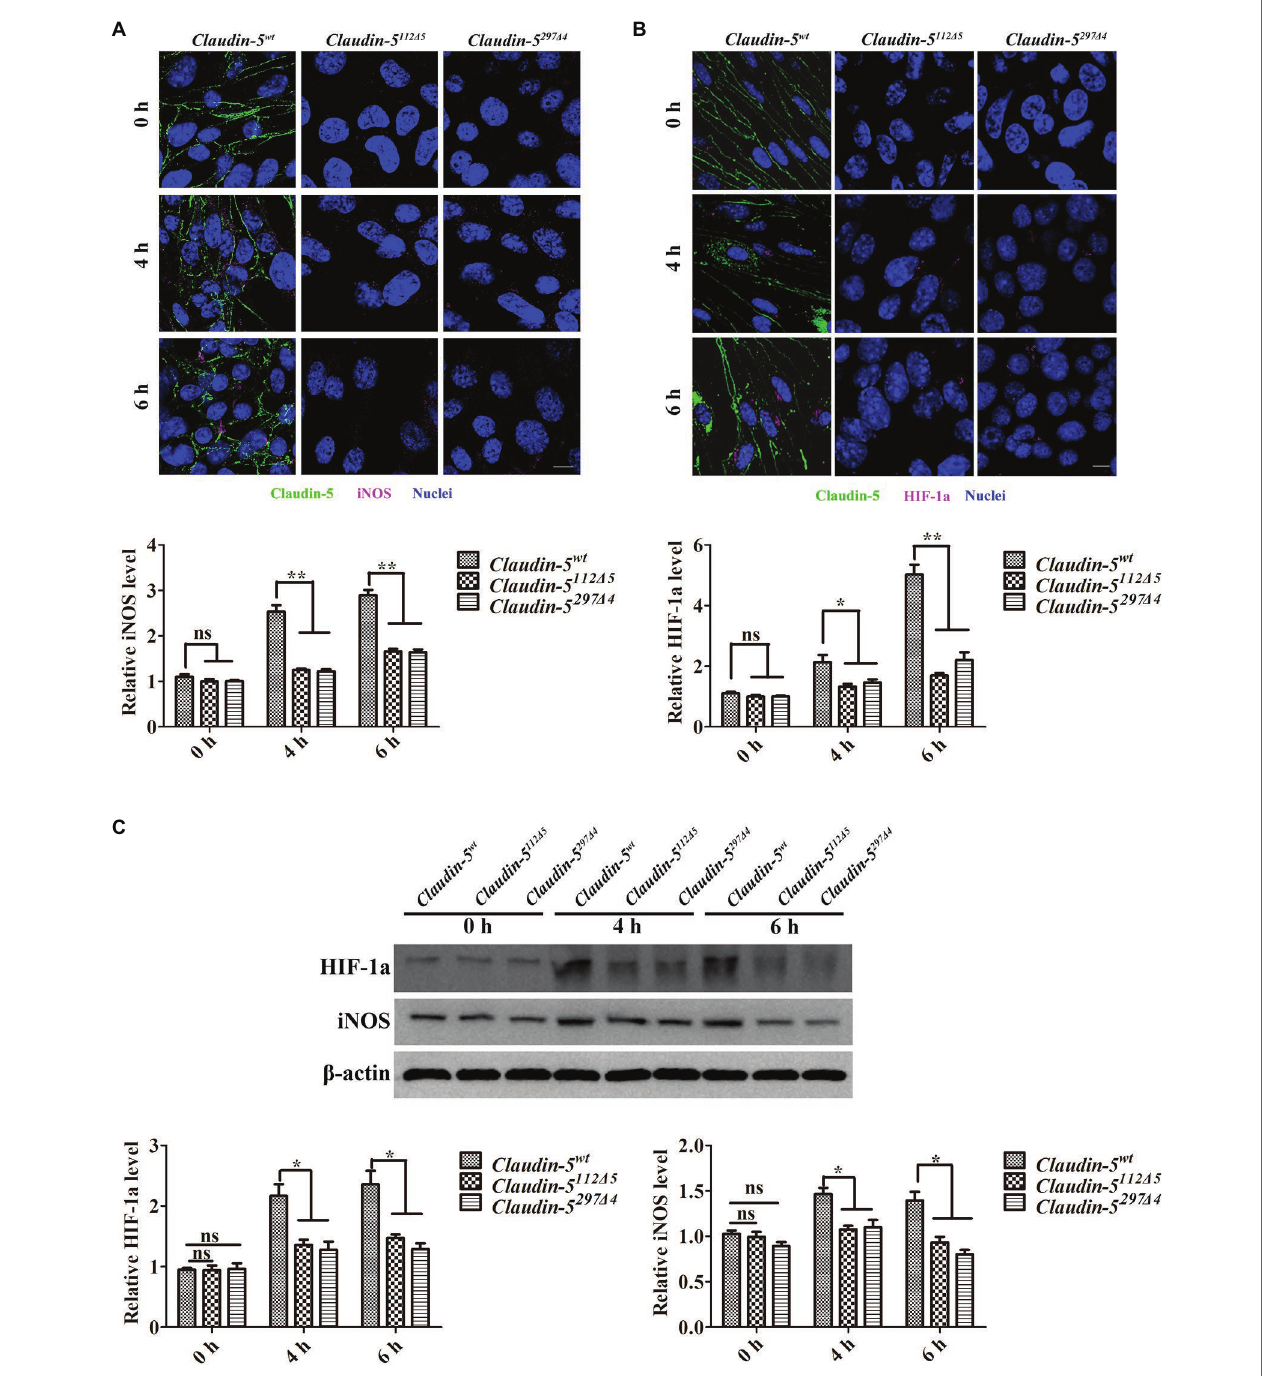
FIGURE 4 | Inducible nitric oxide synthase (iNOS) induces Cav-1-mediated Claudin-5 translocation in response to hypoxia. (A,B) Confocal microscopy images of Claudin-5 (green), iNOS (purple), and hypoxia inducible factor 1 subunit alpha (HIF-1a; purple). Scale bar, 10 μ m. Mean ± SD, n = 3 independent experiments per group. (C) Western blot analysis of iNOS and HIF-1a. Mean ± SD, n = 3 independent experiments per group. * p < 0.05 and ** p <